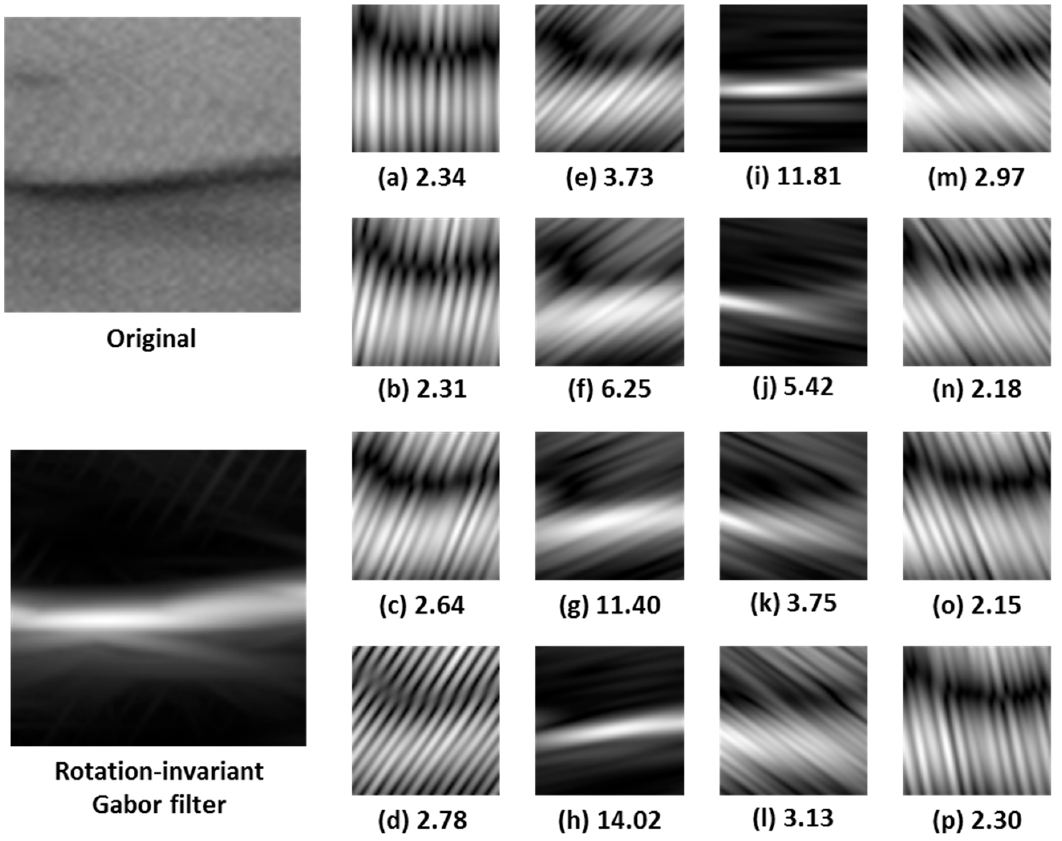
Figure 4. Example of the application of the rotation-invariant Gabor filter. The original image and the result of applying the rotation-invariant Gabor filter to it are shown on the left. The Gabor filters applied along 16 orientations (from 0° to 180°) are shown on the right, along with their maximum values ( a – p ).